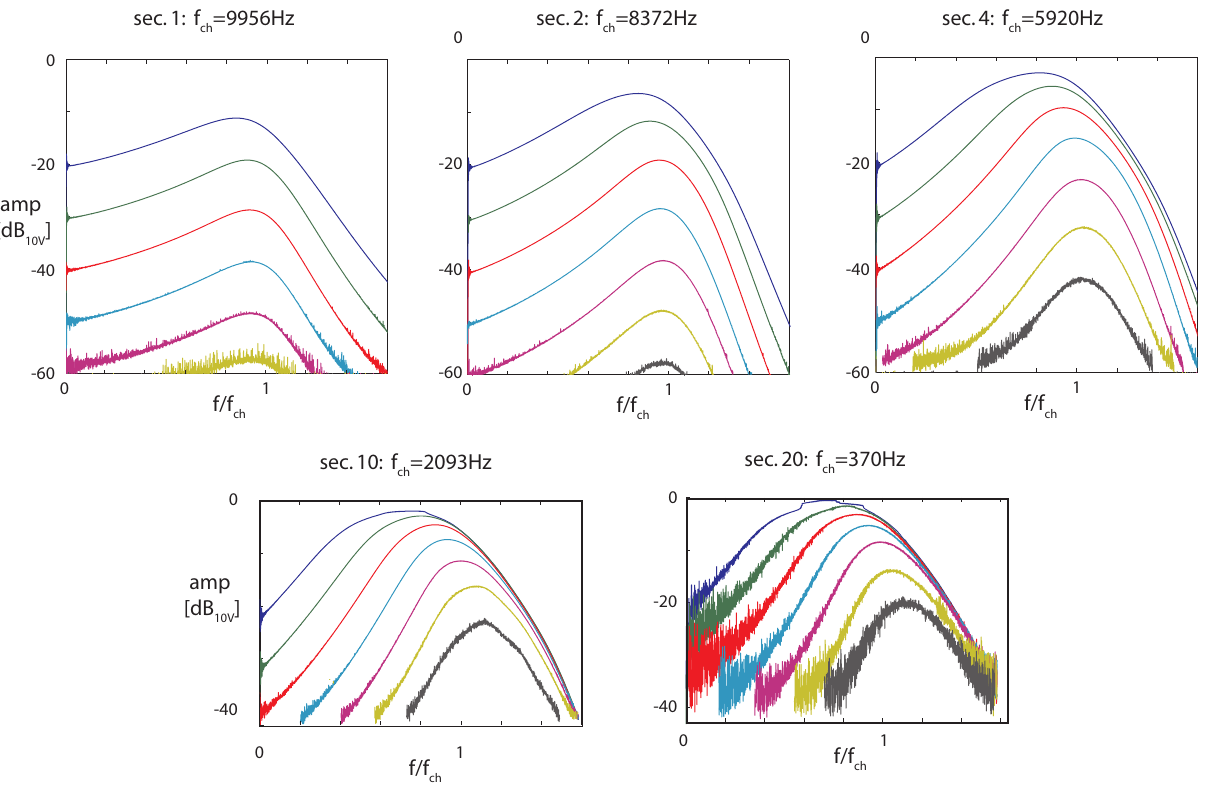
Figure 2 . Output modification by the cochlear cascade: Measurements taken after (from left to right) one, two, ten, twenty sections. µ = − 0 . 2 . Lines of constant inputs are 10 dB apart, ranging from − 20 dB to − 80